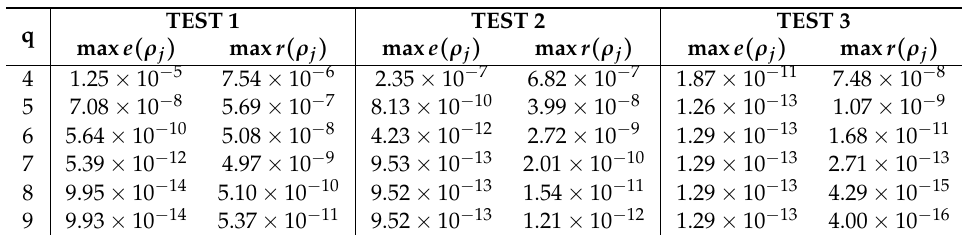
Table 3. Changes of max e ( ρ j ) and max r ( ρ j ) with the number of quadrature nodes q varying from 4 to 9.